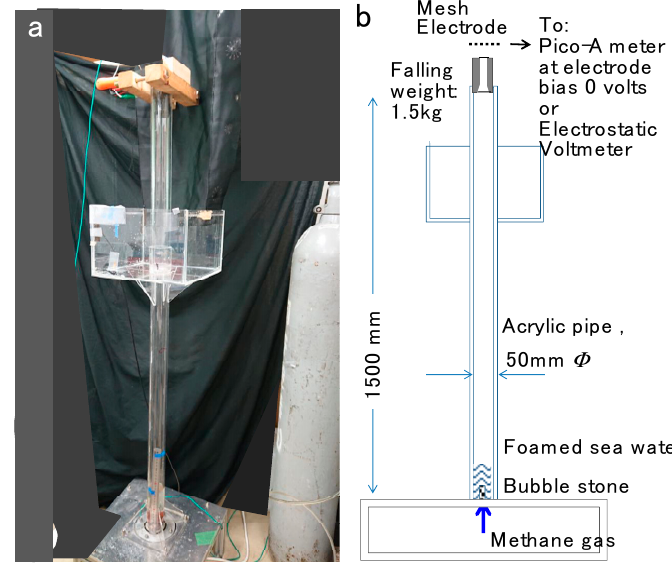
Figure A1. ( a ) Photograph and ( b ) schematic of experimental setup.